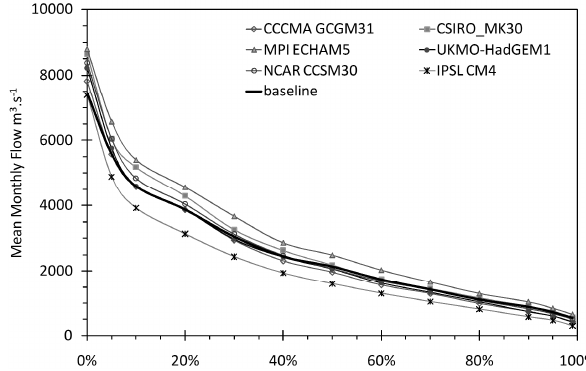
597 Figure 10 : Projected changes in mean monthly flow duration curves under a mean 598 Fig. 10. Projected changes in mean monthly flow duration curves under a mean global temperature rise of +2 ◦ C from six priority global temperature rise of +2°C from six priority GCMs in the Rio Grande basin 599 GCMs in the Rio Grande basin along with the detrended 1961–1990 along with the detrended 1961-1990 baseline or control run. 600 baseline or control 601